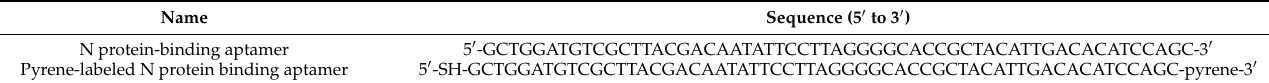
Table 3. DNA sequences used in this